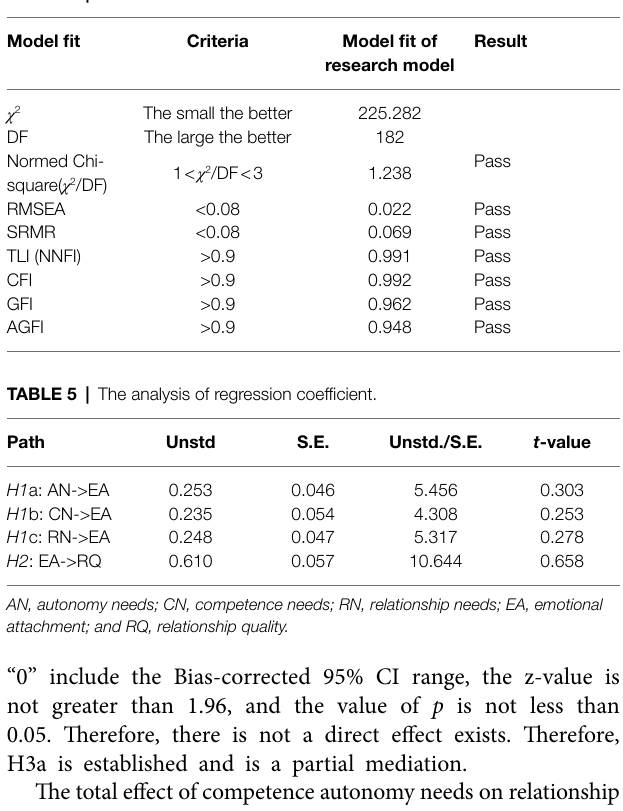
TABLE 3 | The analysis of discriminant validity.